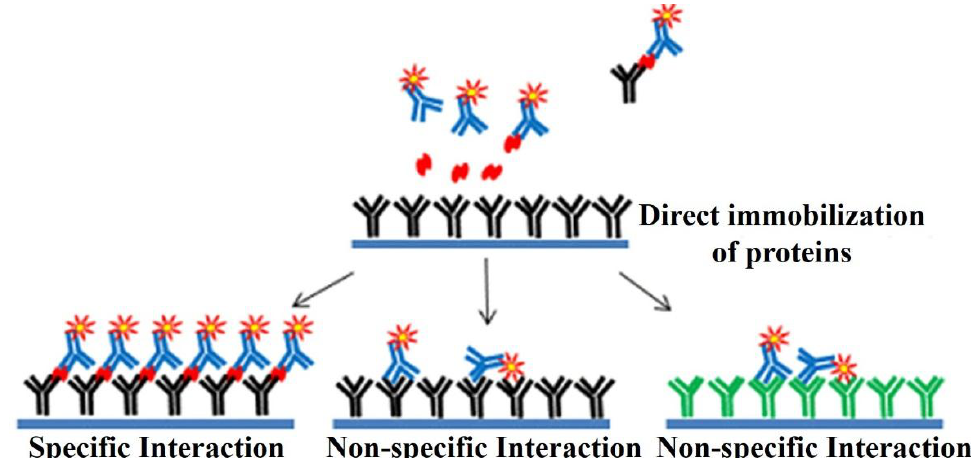
Figure 9. Detection of biomarkers with protein chips obtained by the direct immobilization